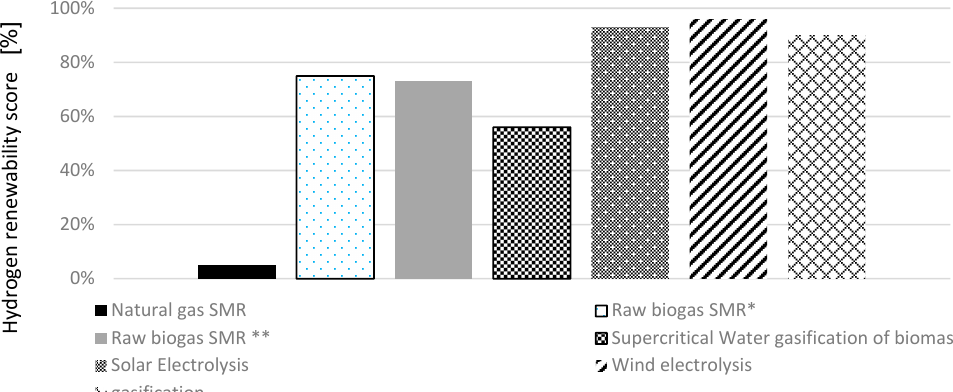
Figure 7. Hydrogen renewability for each technology [6].